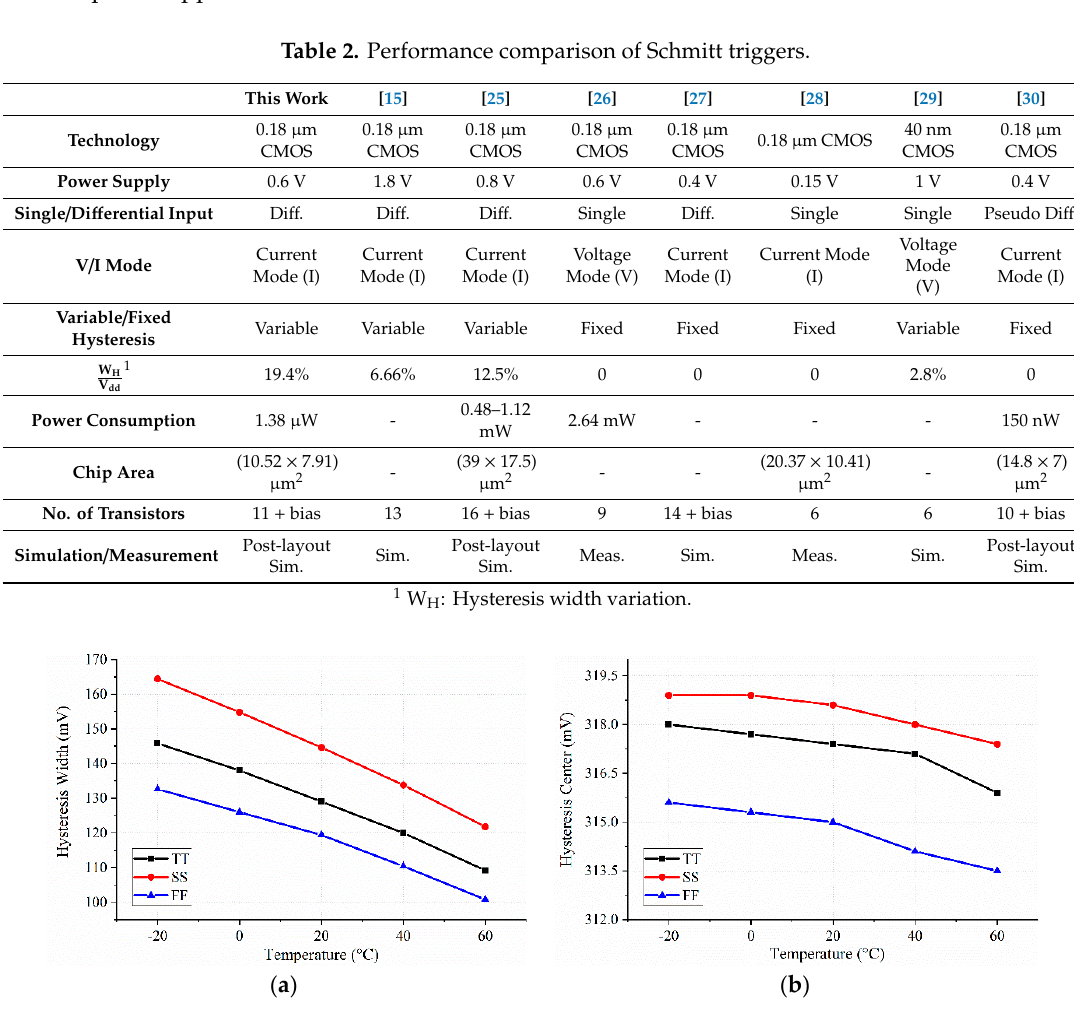
Table 2. Performance comparison of Schmitt triggers.